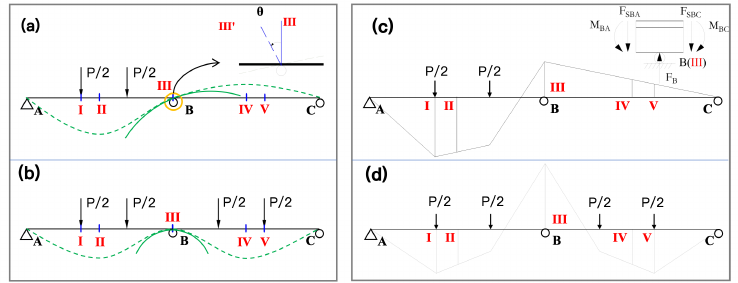
Figure 6. Qualitative deformation of a continuous beam under symmetrical and asymmetrical loading. ( a ) Deformation of the beam SB-1, ( b ) Deformation of the beam SB-2, ( c ) Moment diagram of the beam SB-1, ( d ) Moment diagram of the beam